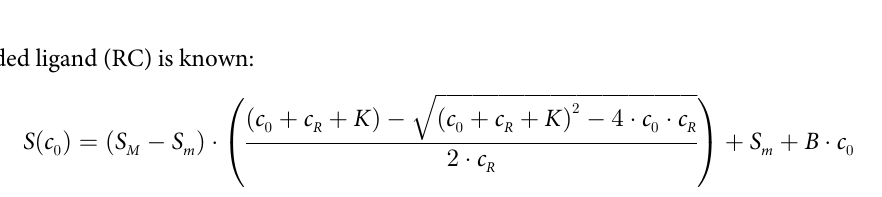
S4 Fig. Alignment of integrin α 2A domains from different species. Sequence comparison of the integrin α 2 A-domain from different vertebrate species. The loop 2 sequence S 214